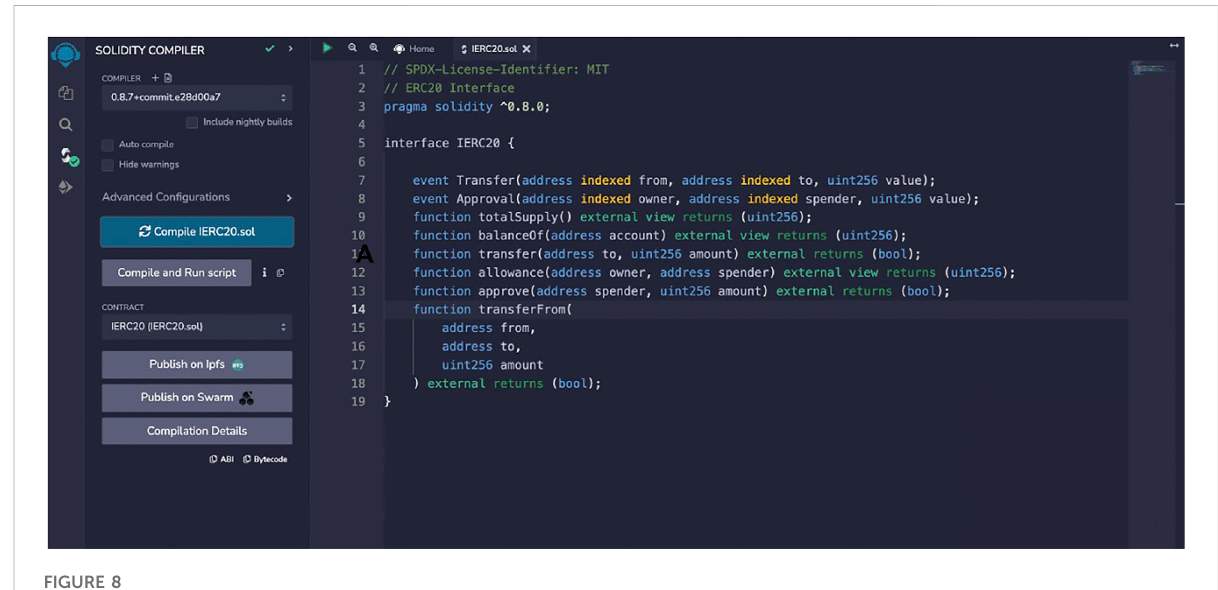
FIGURE 8 Process showing the deduction taken from the buyer ’ s wallet.